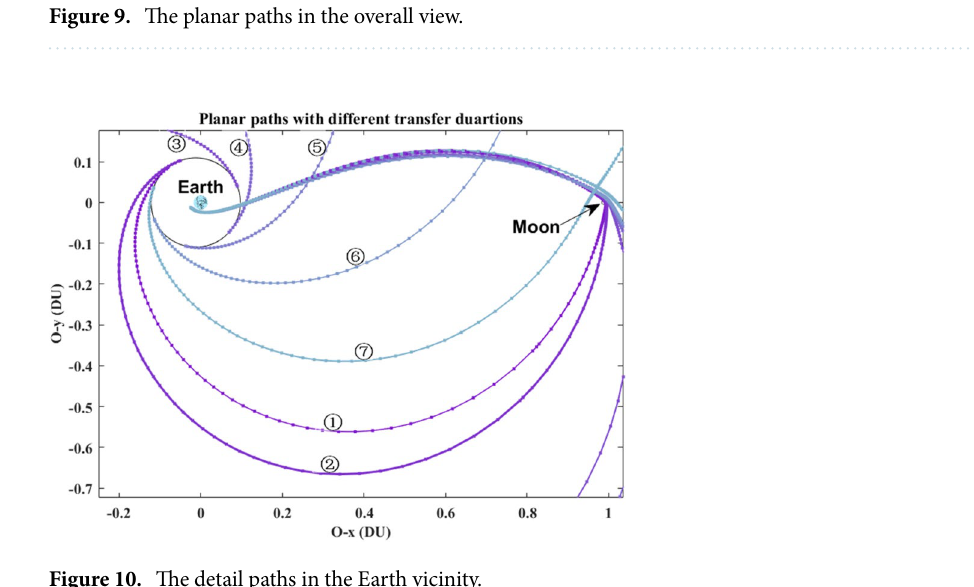
Figure 10. The detail paths in the Earth vicinity.